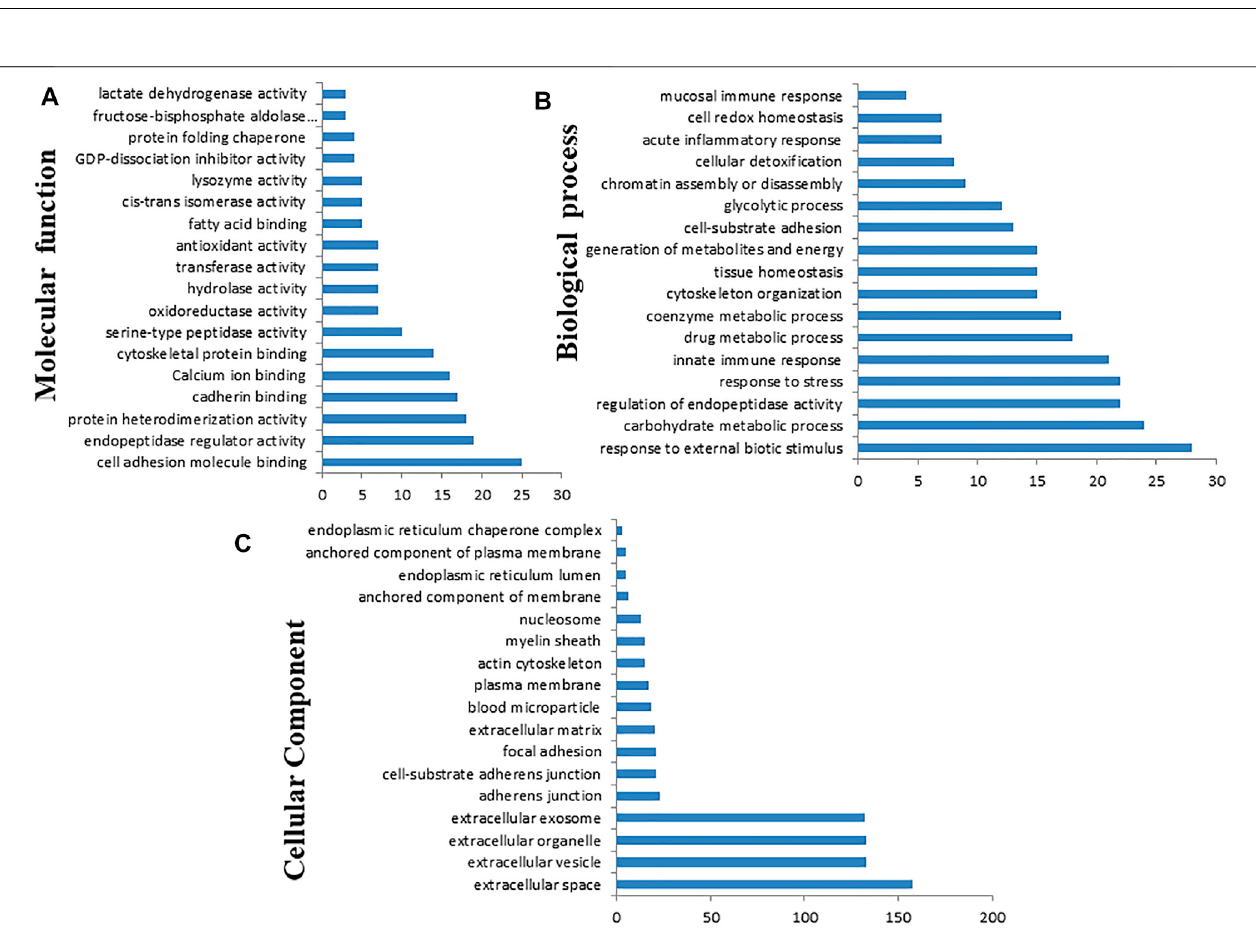
FIGURE 12 | Gene Ontology (GO) classi fi cation of the differentially expressed proteins based on molecular function (A) , biological process (B) , and cellular component (C) using Cytoscape software with ClueGO plug-in.